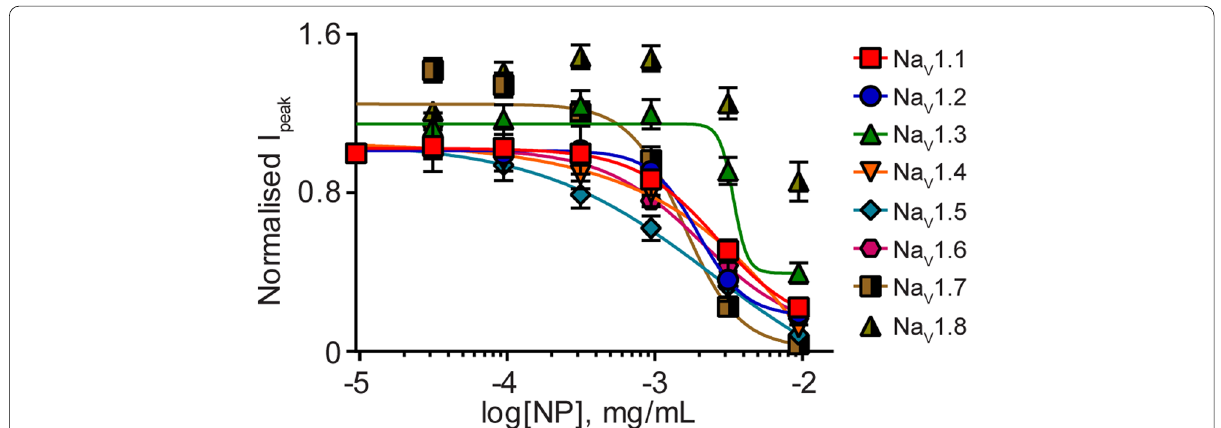
Fig. 4 Variable potency of NP for the Na V 1.1-Na V 1.8 channels. Concentration-response curves for NP (0.03–9 μg NP/mL) against Na V 1.1 ( ; n Na V 1.2 ( ; n 6), Na V 1.3 ( ; n = mean SEM ±